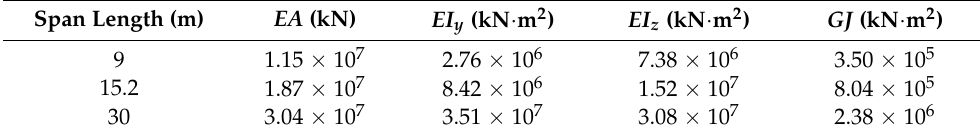
Table 4. Section properties of open-deck steel plate girder bridge calculated by 3D FE analysis.